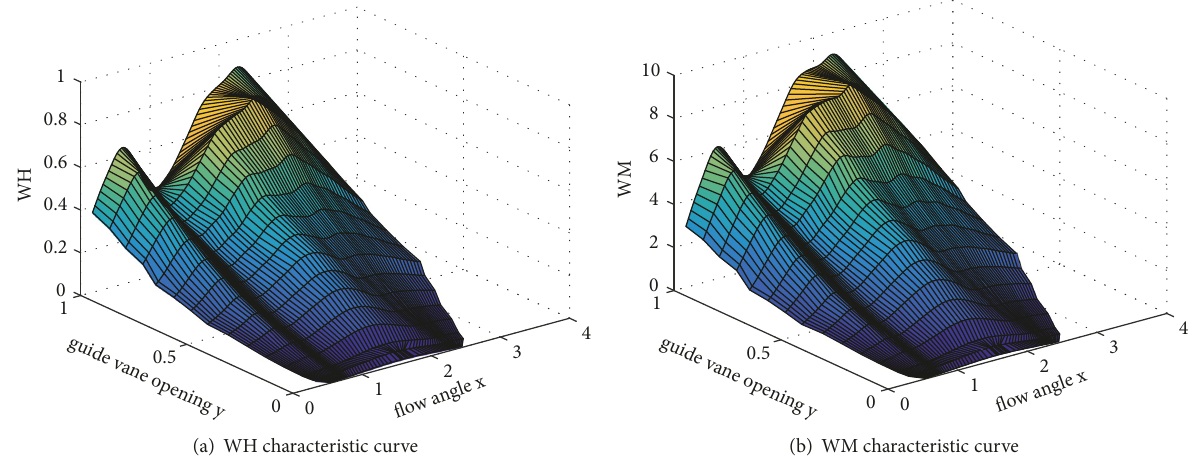
Figure 2: Three-dimensional surface of the characteristic curves of pump